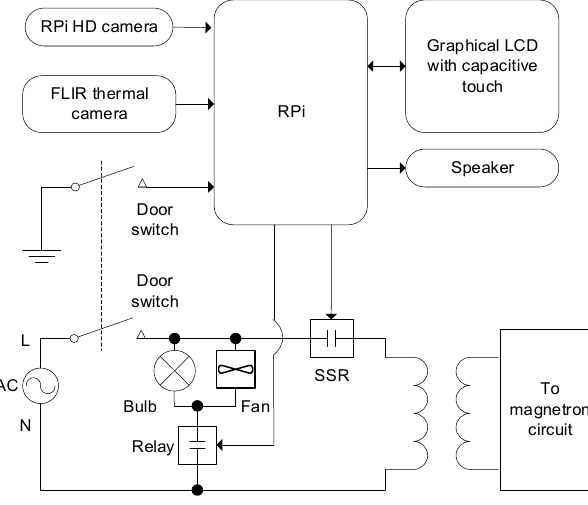
Figure 5. Block diagram of the hardware.